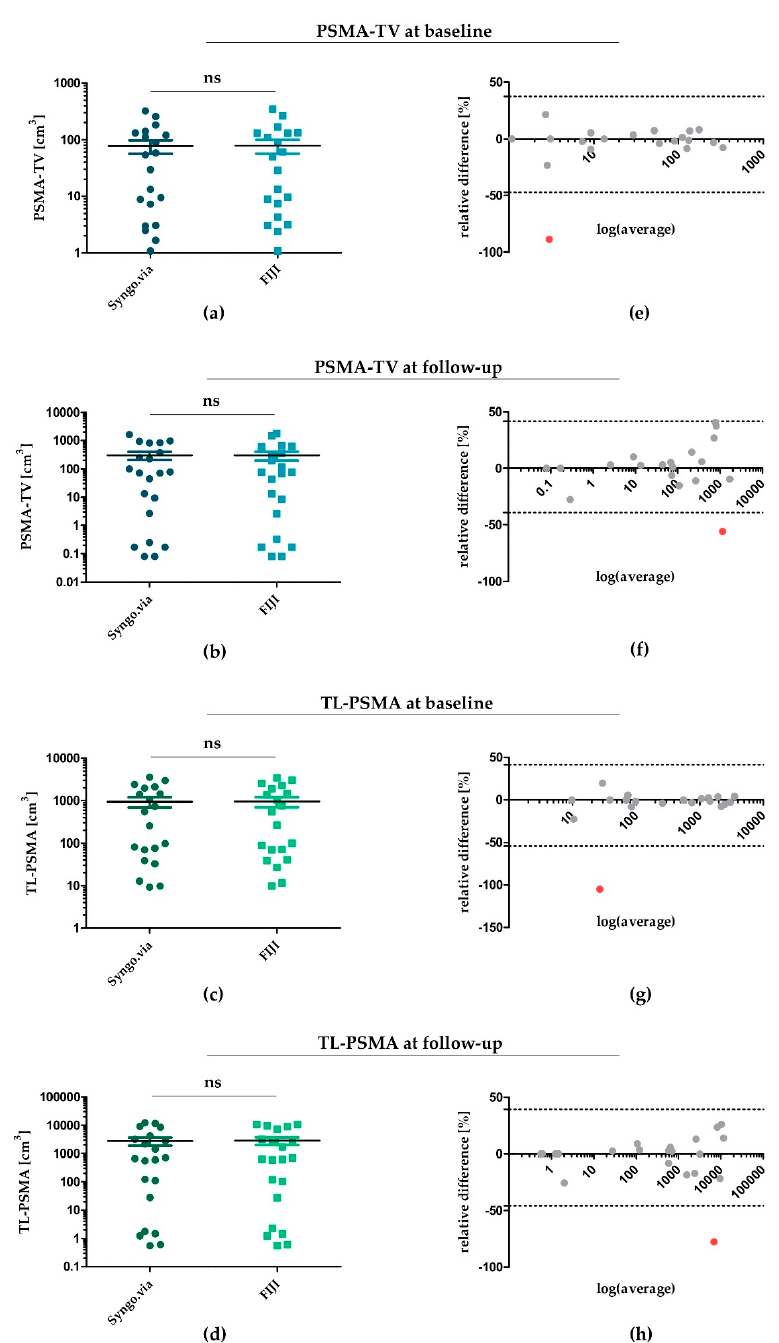
Figure 1. Statistical agreement of PSMA-TV and TL-PSMA determined by Syngo.via and FIJI at baseline and follow-up. ( a , b ) PSMA-TV for each patient at baseline ( a ) and follow-up ( b )—determined by Syngo.via and FIJI. ( c , d ) TL-PSMA at baseline ( c ) and follow-up ( d ) determined by both software algorithms. ( e – h ) Bland–Altman diagrams for illustration and assessment of statistical comparability for each patient. Single outliers with a significant divergence between values determined by Syngo.via and FIJI were marked in red—all others were depicted within a range of 1.96 × standard deviation (SD). PSMA: prostate-specific membrane antigen; PSMA-TV: PSMA tumour volume; TL-PSMA: total lesion PSMA; ns: not